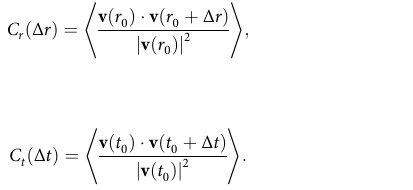
explore if boundary conditions governing interface growth and form of passive interfaces may be extended or adapted to active interfaces.